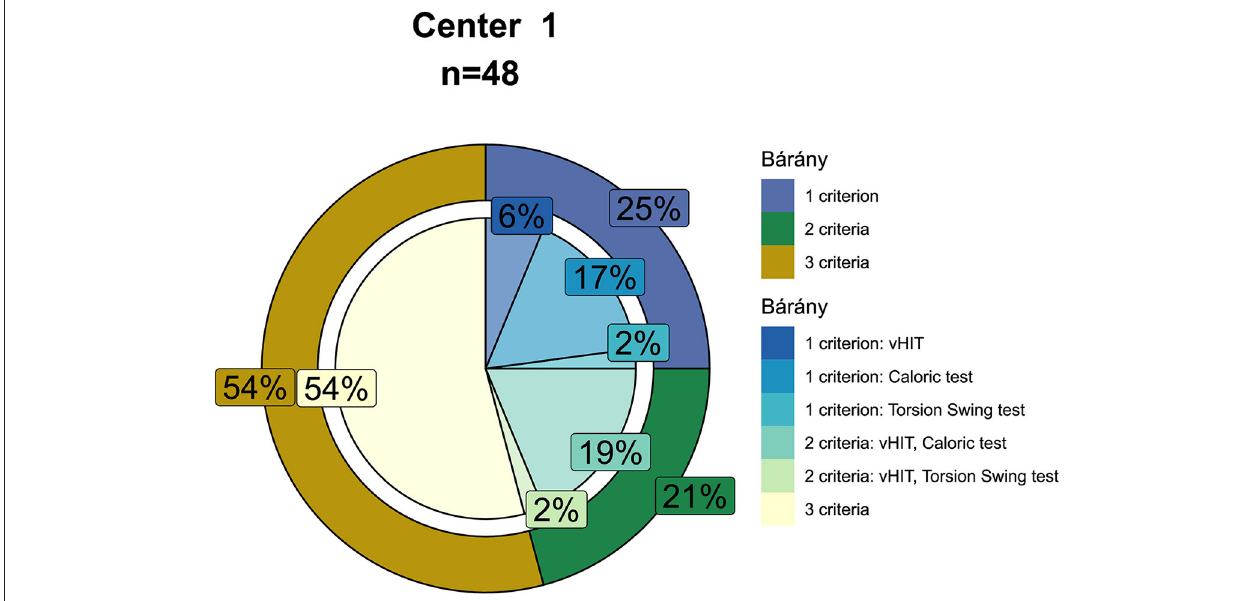
FIGURE 5 | Percentages of patients with BVP meeting one, two or three of the diagnostic criteria of the Bárány Society (shown in the outer circle, i.e., a reduced bithermal caloric response with a sum of the bithermal maximal peak slow phase velocity < 6 ◦ /s bilaterally and/or a VOR gain < 0.1 during torsion swing test at 0.01Hz and/or a bilaterally reduced horizontal video Head Impulse Test gain of < 0.6). The inner-circle shows the percentages of which tests are met by patients meeting one or two of the diagnostic criteria. Only cases without missing data for caloric testing, torsion swing test, and horizontal video Head Impulse Test were included (center 1, n =